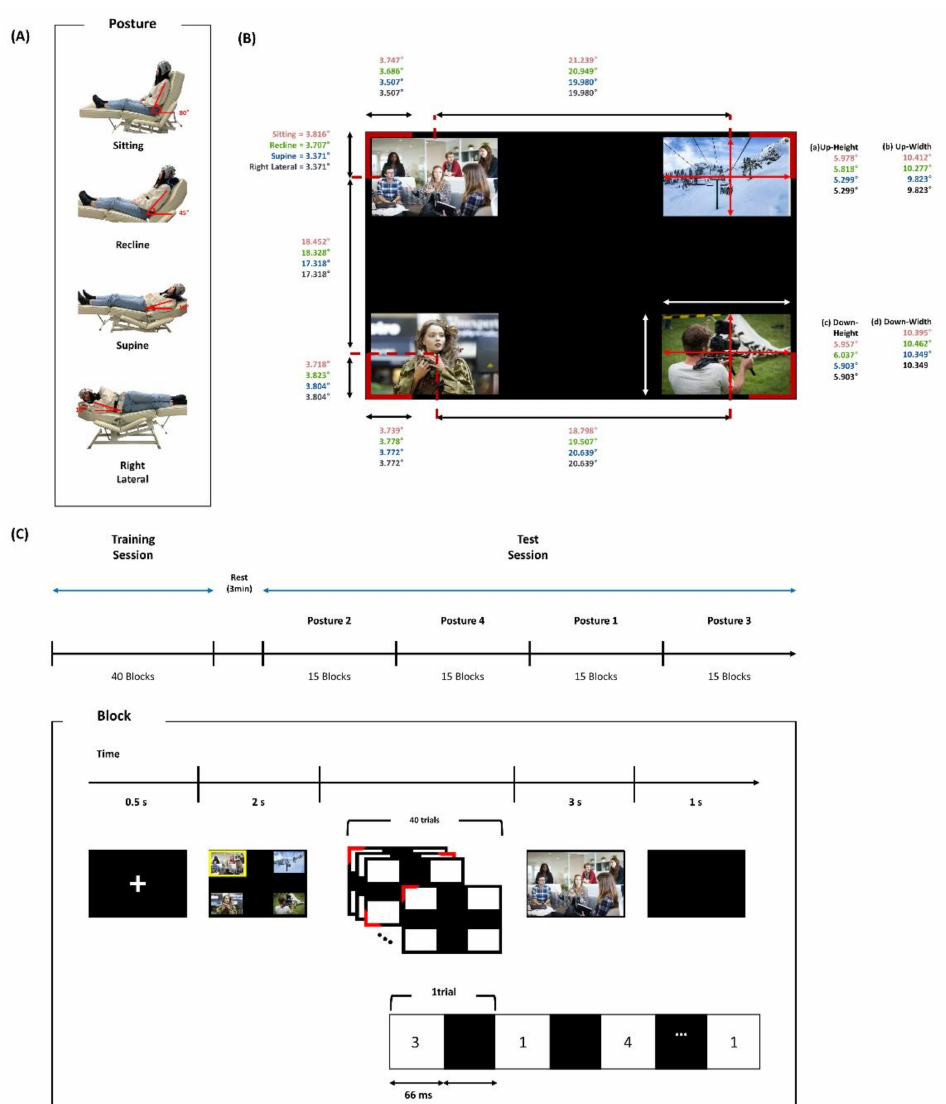
Figure 1. ( A ) Types of postures used in this experiment: sitting, recline, supine, and right lateral posture. The red angles denote the size of the angle between a vertical axis on a sagittal plane and a flat floor for sitting, recline, supine, and right lateral postures. ( B ) Visual stimuli and visual angles for each stimulus in each posture. The red text indicates the visual angle in the sitting posture, the green in the reclining posture, the blue in the supine, and the black is in the right lateral recumbent posture. The visual angles for the height and width of the presented video clip at the upper side (a,b) and lower side (c,d) are described next to the visual stimulus. The represented image of the video clips was replaced by that of copyright-free videos due to the copyright of the video clips used in this experiment. ( C ) Experimental protocol. Subjects performed a task of selecting one of the TV channels using the P300 BCI in four different postures. A block corresponds to one selection of a target